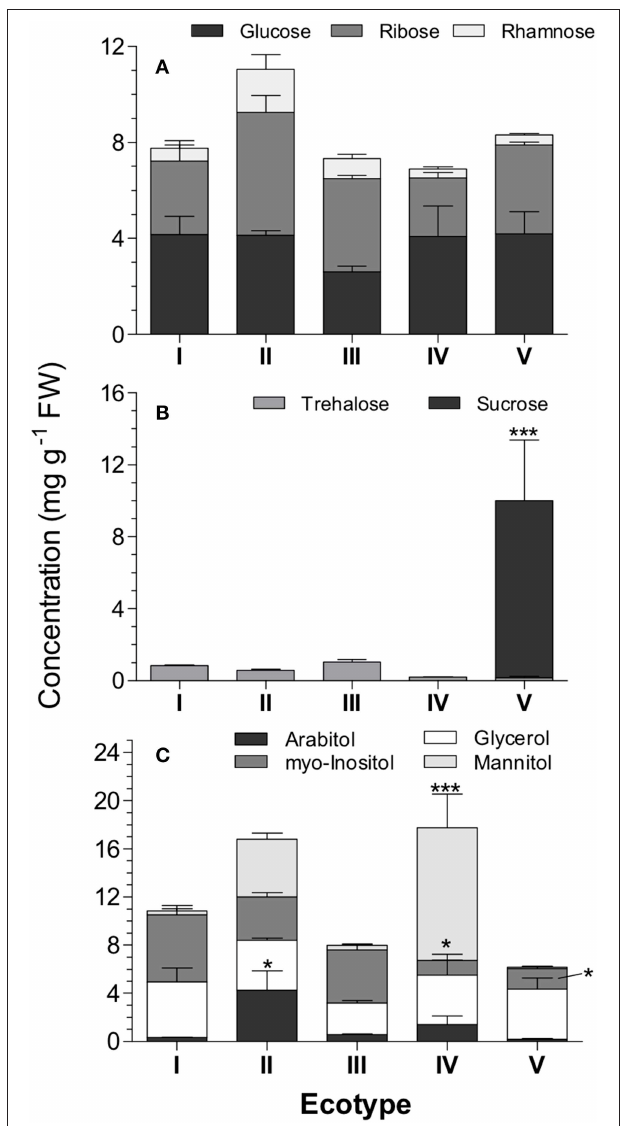
FIGURE 5 | Sugar composition of R. communis elaiosomes. (A) Monosaccharides, (B) Disaccharides, (C) Sugar alcohols. Data represents mean ± SE (mg g − 1 FW) of the sugars as measured using GCMS analysis. Bonferroni’s post-hoc test was done to separate the means after two-way ANOVA. Asterisk indicates significant differences in individual sugar concentration between varieties ( p ≤ 0.01, n = 5).